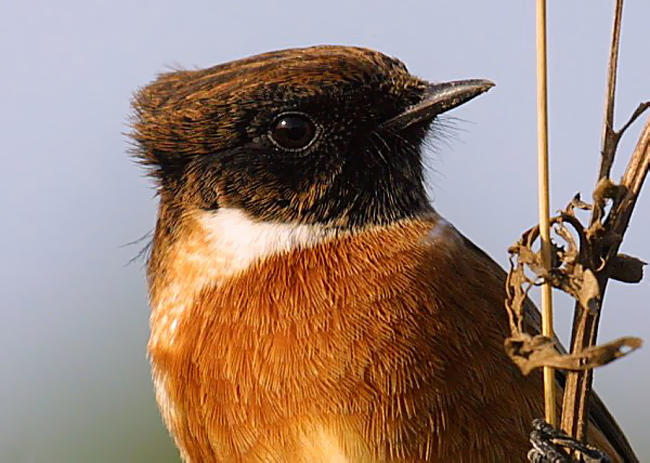
Recording migratory restlessness in resident African stonechats (the European stonechat is pictured above) suggests that nonmigratory birds retain an innate program supporting a seasonal urge to migrate.